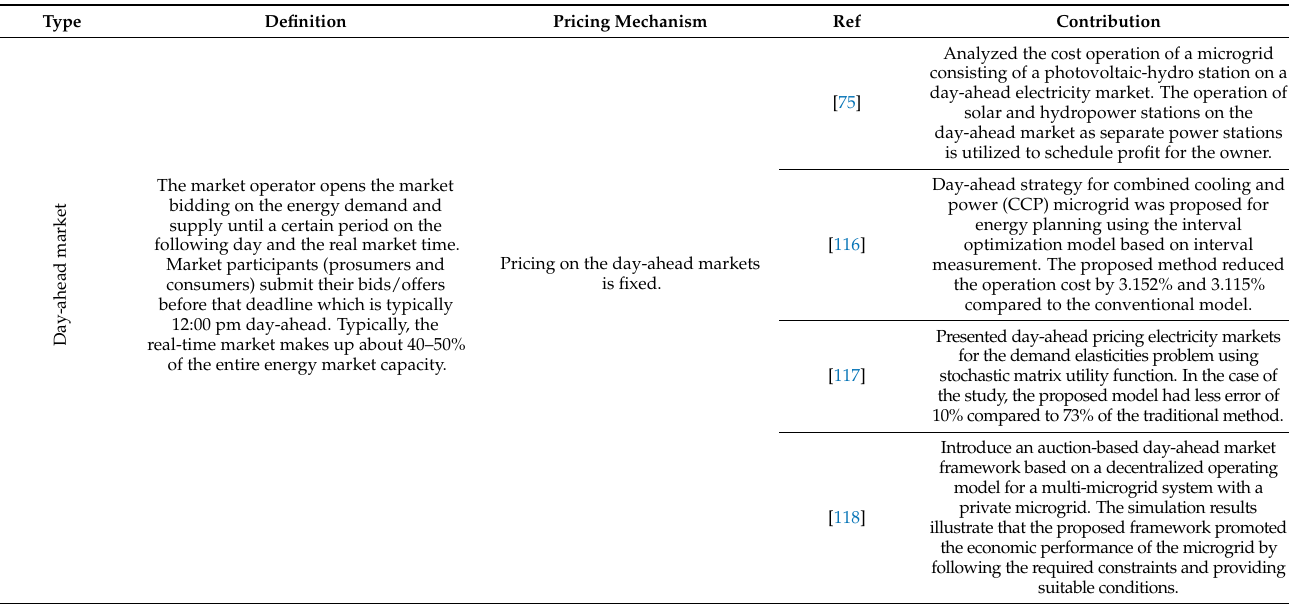
Table 3. Comparison of different market designs day-ahead, intraday, and real-time